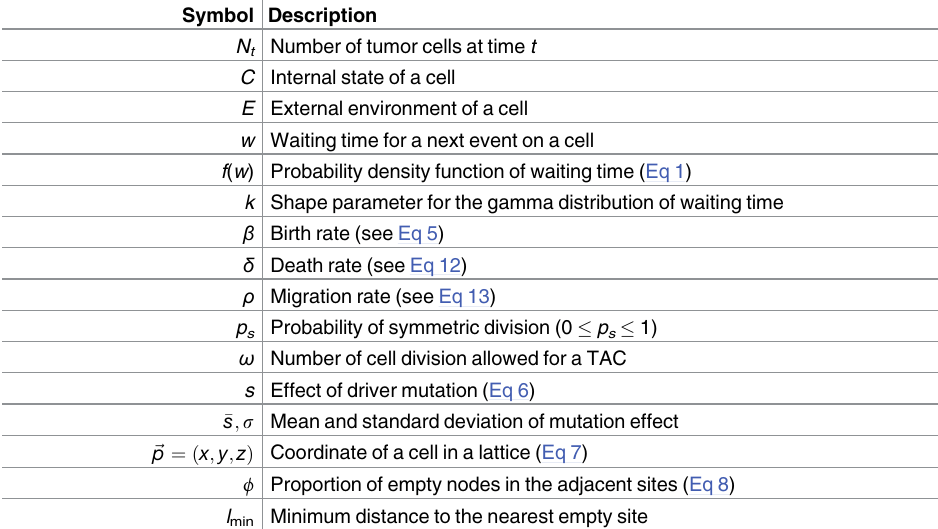
Table 1. Summary of the symbols in this